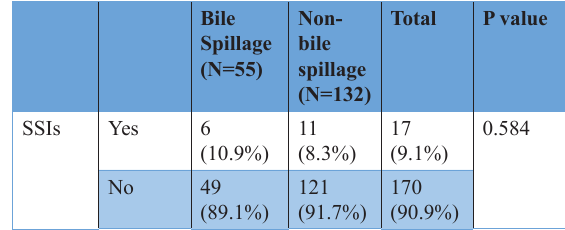
Table 2. Preoperative diagnosis of patients with bile spillage and non-bile spillage during laparoscopic cholecystectomy. Pre-operative